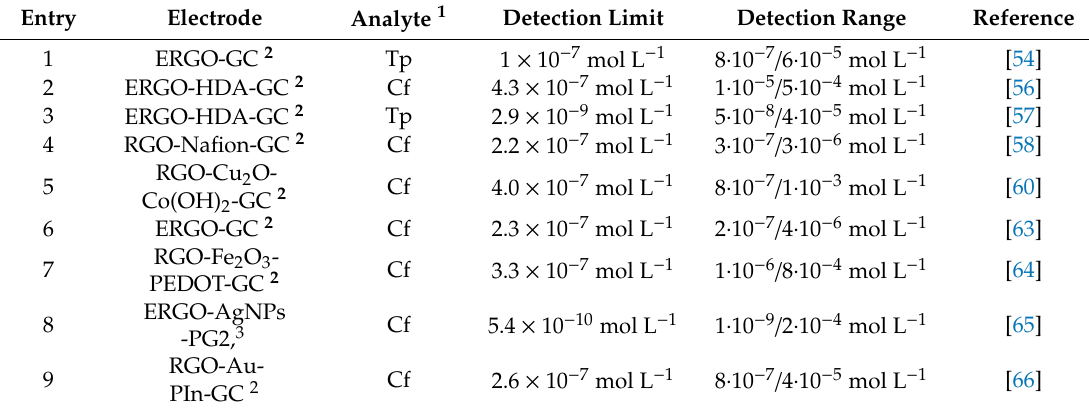
Table 4. Schematic overview on the use of RGO and ERGO in electrochemical sensors for natural methylxanthynes (see